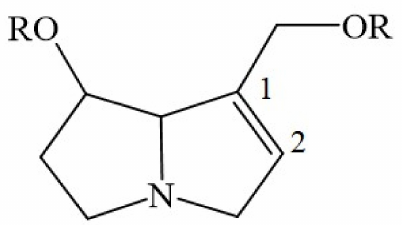
Figure 1. Prototypical basic structure of a toxic 1,2-unsaturated pyrrolizidine alkaloid; a sketeletal formula of retronecine, a PA found in the Common groundsel ( Senecio vulgaris ) and comfrey ( Symphy- tum spp.). R illustrates the position of the different necic acids. Of note, the chemical structure of non-toxic PAs is similar to the structure shown above except that the double bond between C1 and C2 is missing. Structure was composed from various publications